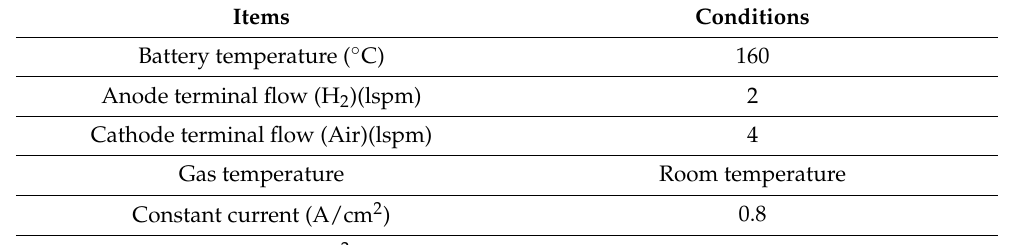
Table 2. Test conditions of HT-PEMFCs.